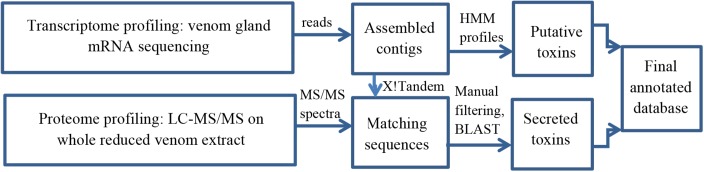
Schematic workflow used to obtain total profiling of venom and venom gland toxins.